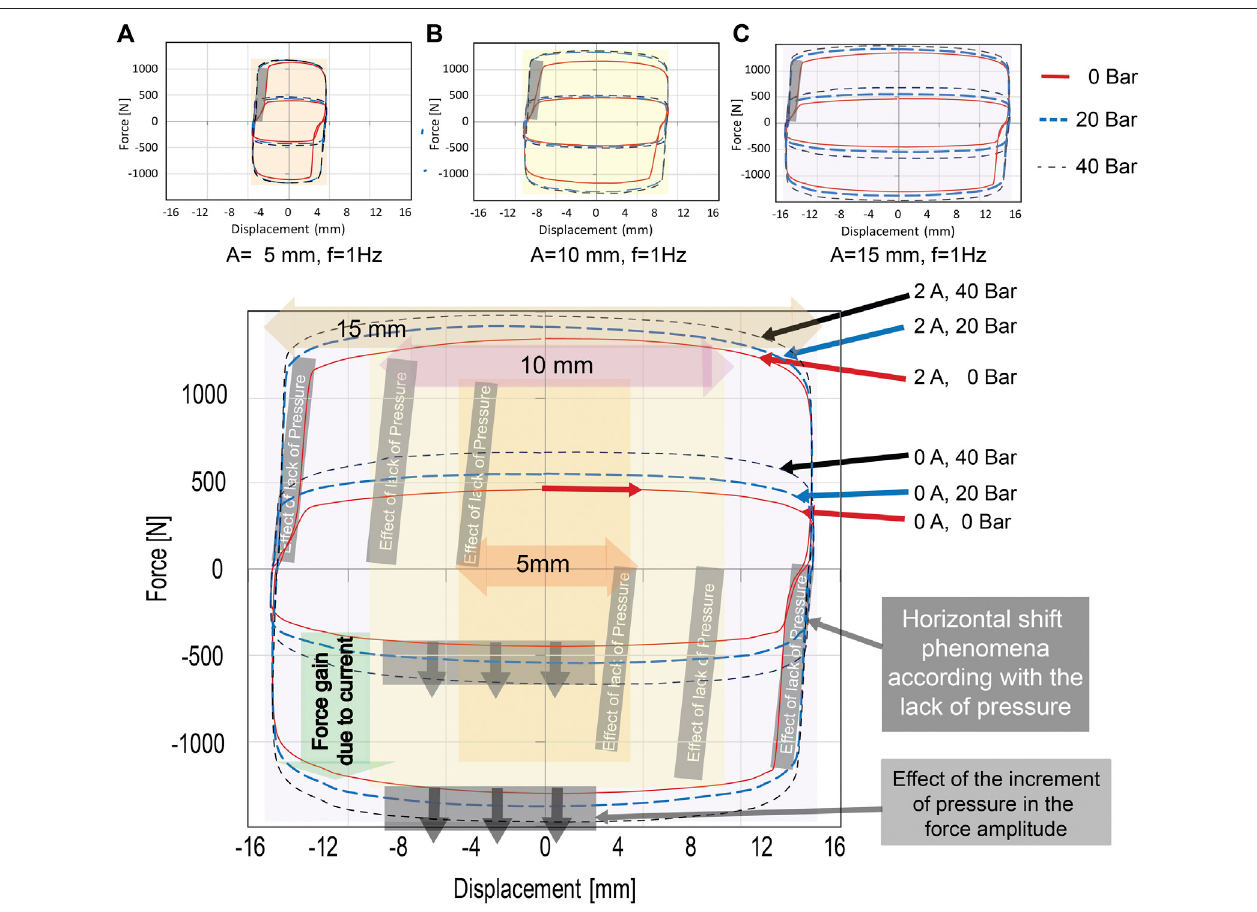
FIGURE 13 | FD Characteristic diagrams for a 2 Degrees of Freedom MR shock absorber for the three cases of electric current (0, 1 and 2 A) and pressure (0, 20 and 40 bar). The fi rst upper row shows the three FD diagrams for the different amplitudes. The second row shows the FD diagram, where it is emphasized the effects of pressure and electric current on the damping force, and how it changes according to the displacement amplitude.